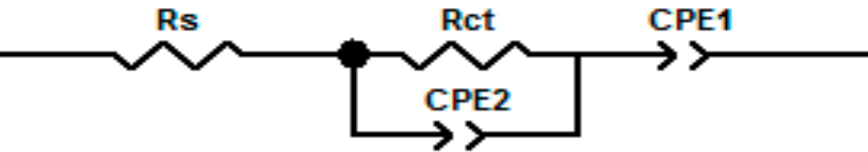
Figure 9. Equivalent circuit diagram for the electrode systems. (R s = solution resistance; R ct = charge transfer resistance; and CPE = constant phase element).